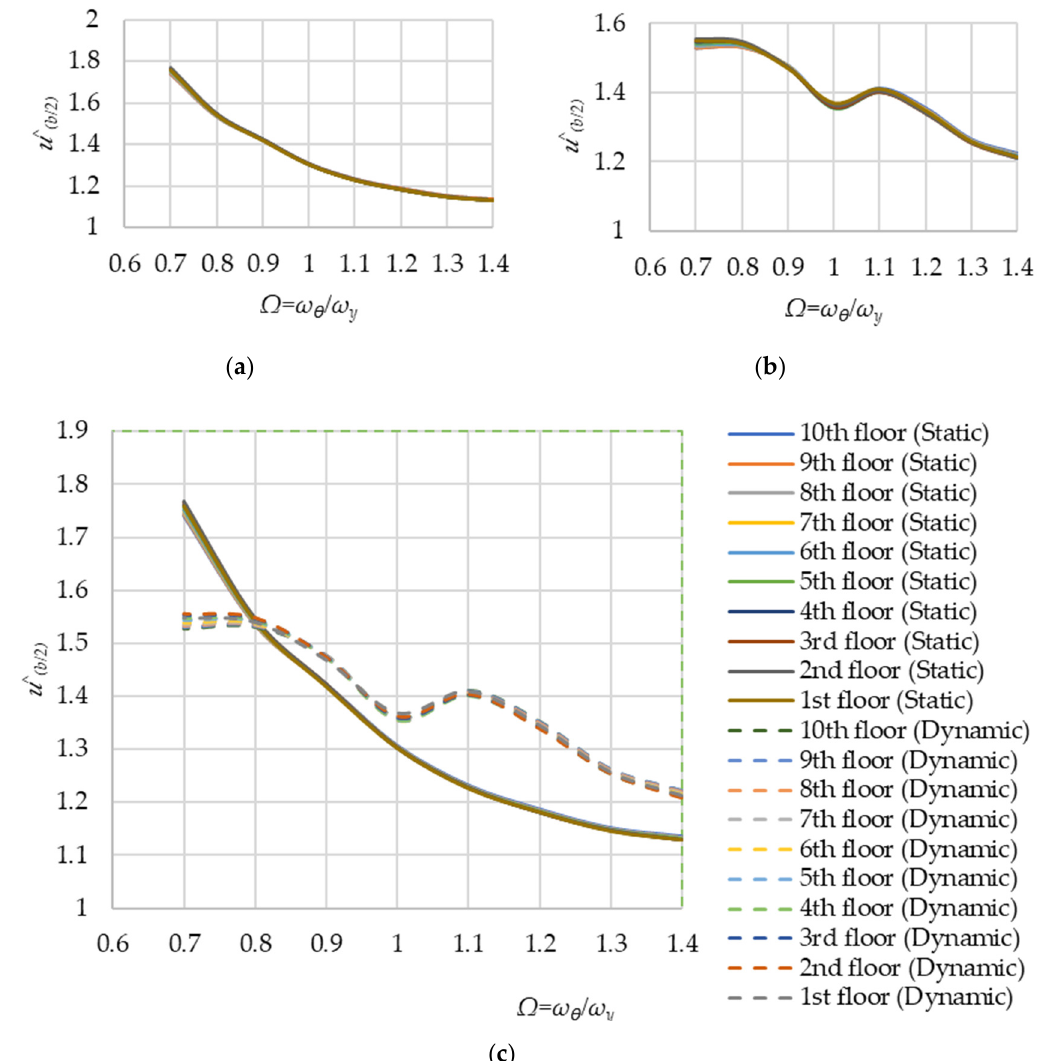
Figure 6. Normalized flexible edge displacement (with b / r = 1.1, 1 < Ty < 2 s): ( a ) Static edge displacement; ( b ) Dynamic edge displacement; ( c ) Static vs. dynamic edge displacement.